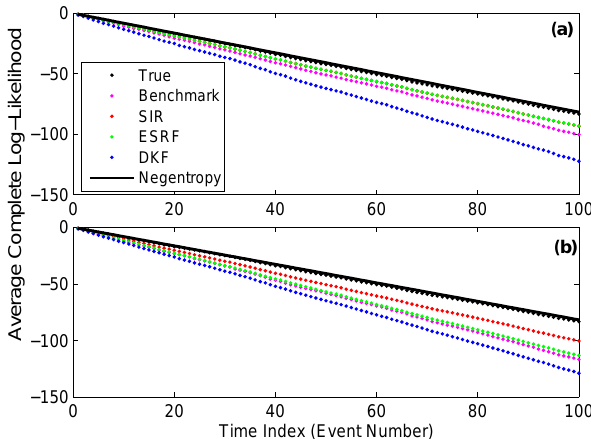
Fig. 4. Evolution of the sample mean of the cumulative complete log-likelihood, averaged over 100 realizations of a 100-event point process. Same explanation as for Fig.